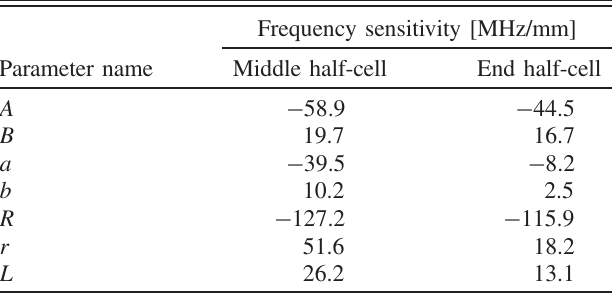
TABLE II. Frequency-dependent sensitivities of the operating π mode for the geometrical parameters of the 3.9 GHz LCLS-II